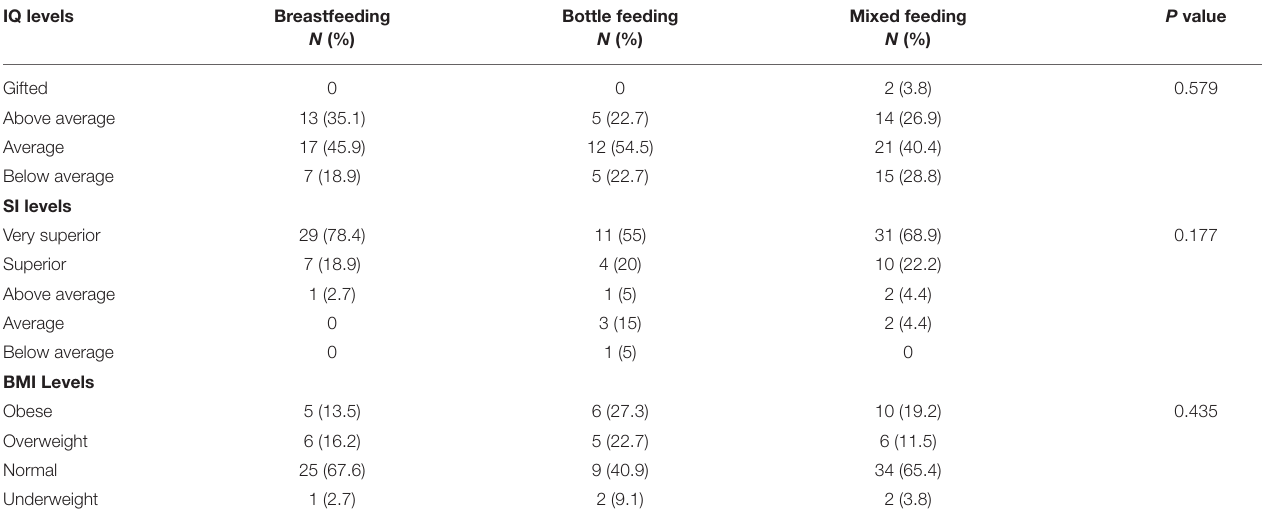
TABLE 2 | Distribution of IQ, SI, and BMI results among participants.